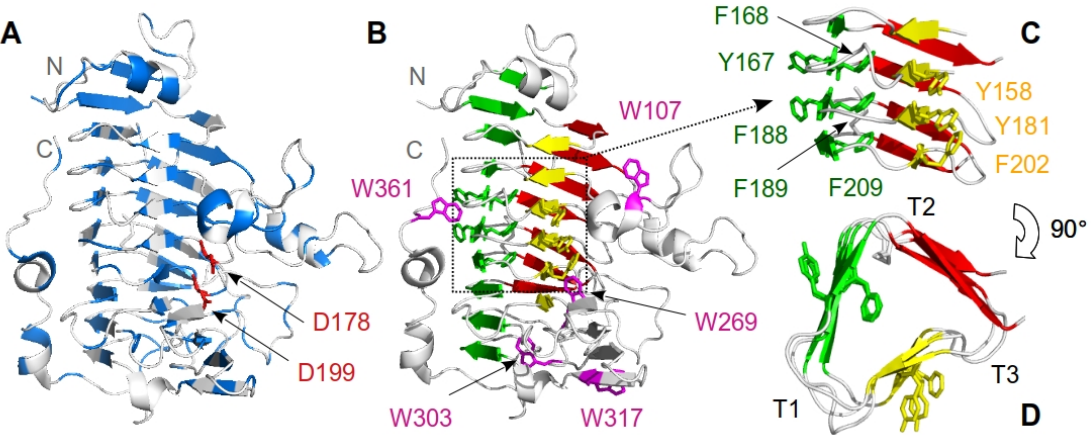
Figure 1. Schematic ribbon representation of the structure of Erwinia chrysanthemi 3937 pectin methylesterase (2NSP, [49]). The secondary structure elements are shown with ( A ) the hydrophobic residues in blue and the catalytic aspartate residues in red, ( B ) the three β -sheets in yellow (PB1), green (PB2), and red (PB3), and the tryptophan residues in purple. A closer view on the aromatic stacks in the central part of the β -helix is shown from ( C ) side and ( D ) top views. N and C indicate the N- and C-terminal ends of the polypeptide chain, respectively, and T1, T2, and T3 correspond to the turns following the three β -sheets. The figure was drawn using the open-source molecular graphics system PyMOL.